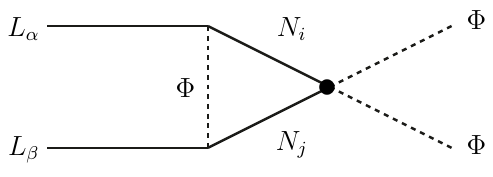
Figure 1 . One loop contribution of